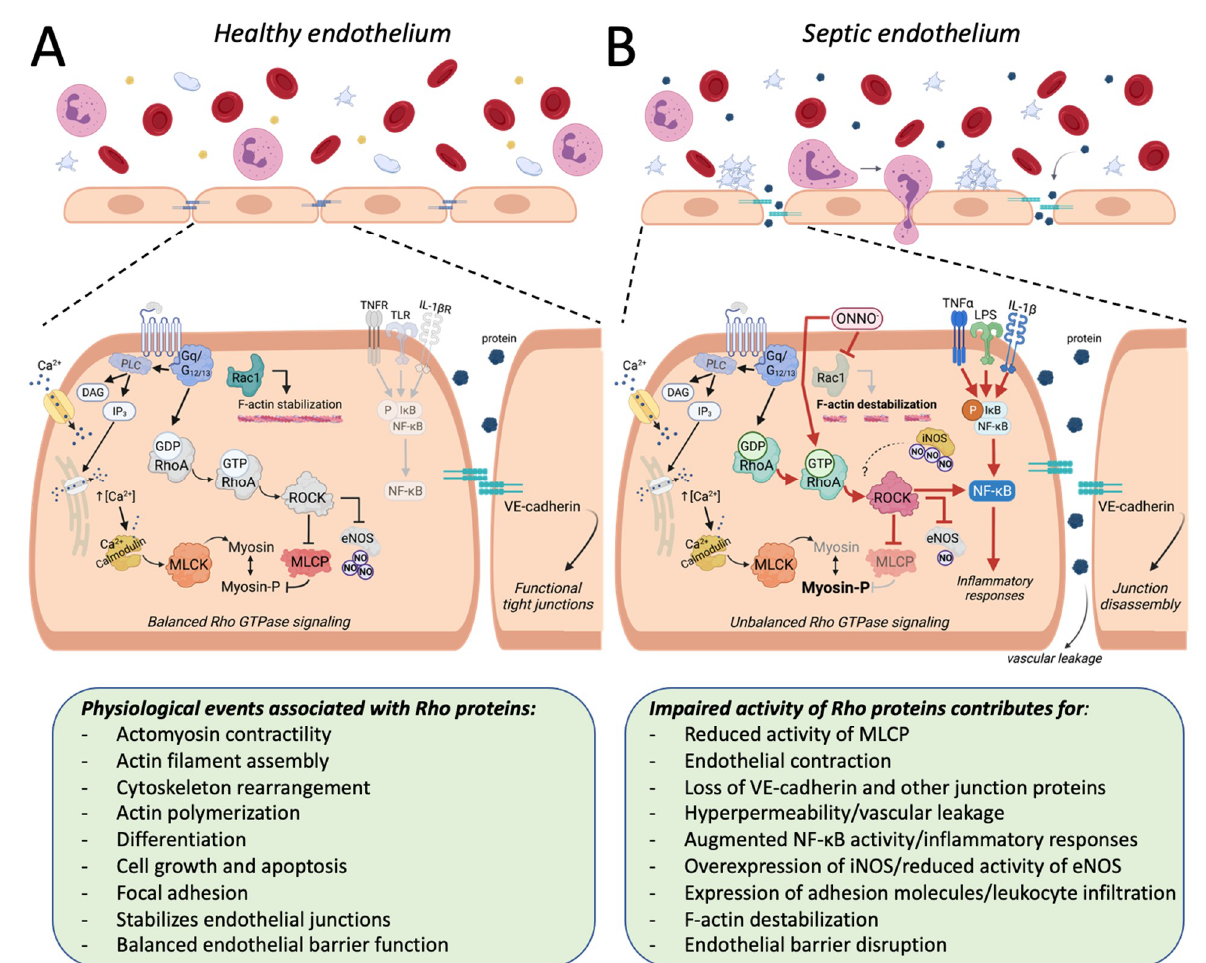
Figure 2. The influence of Rho proteins on the endothelial function in sepsis-associated experimental models. Rho proteins have been involved in several physiological responses. In healthy endothelial cells ( A ), these responses include Rac1- mediated F-actin stabilization and the regulatory effect of the RhoA/ROCK pathway on the activity of enzymes such as the myosin light chain phosphatase (MLCP) and the endothelial nitric oxide synthase (eNOS). The balanced activity of Rho proteins contributes to the maintenance of the endothelial barrier function. Under experimental models of sepsis ( B ), systemic or locally produced mediators (i.e., ONNO, cytokines) reduce the activity of Rac1 (light gray arrow), contributing to F-actin destabilization, and the activity of the RhoA/ROCK pathway is increased (see the enhanced colors and ticker red arrows), resulting in reduced inhibition of MLCP and augmented levels of phosphorylated myosin (Myosin-P). This unbalanced Rho signaling contributes to exacerbating inflammatory responses, endothelial contraction, loss of junction proteins (i.e., VE-cadherin), endothelial barrier dysfunction, leukocyte infiltration, and vascular leakage, among others. The question mark coming from iNOS in panel B indicates that it remains unclear whether the high amounts of NO produced during septic insults significantly influence the activity of the RhoA/ROCK pathway in endothelial cells. PLC, phospholipase C; DAG, diacylglycerol; IP3, phosphatidylinositol 1,4,5-trisphosphate; MLCK, myosin light chain kinase; TNFR, tumor necrosis factor α receptor; TLR, Toll-like receptor 4; IL-1βR, interleukin 1β receptor.